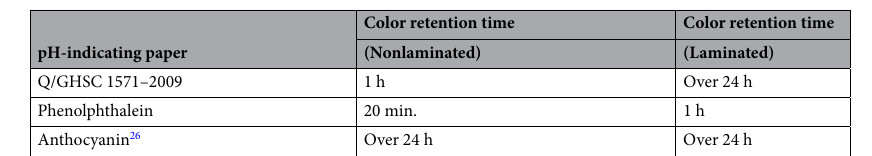
pH-indicating paper